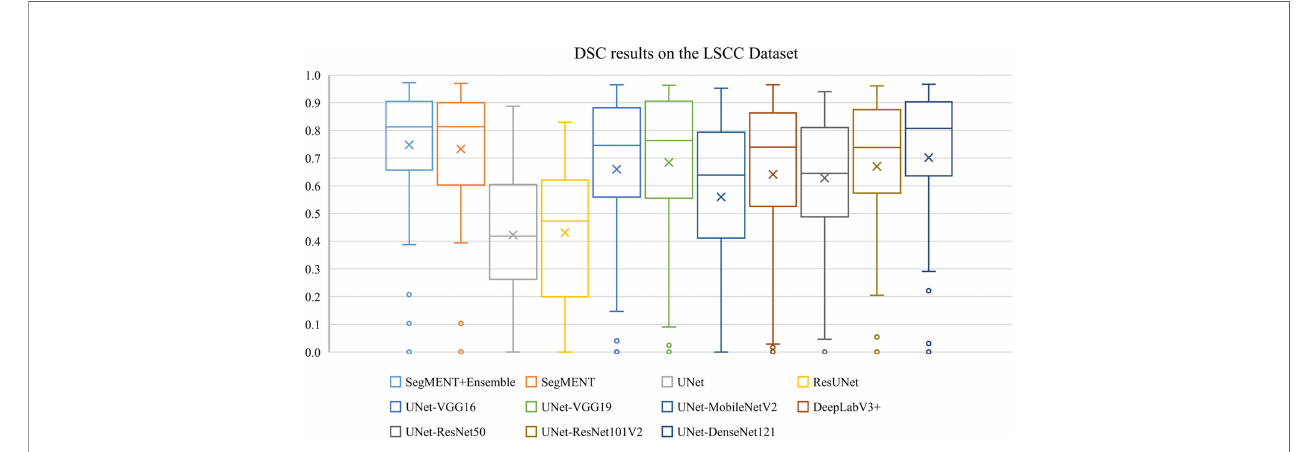
FIGURE 7 | Boxplots of Dice similarity coef fi cient (DSC) results from SegMENT ensemble and the other state-of-the-art segmentation models on the laryngeal squamous cell carcinoma (LSCC) dataset. The cross sign represents the mean value, while the horizontal line inside the boxplot shows the median value.